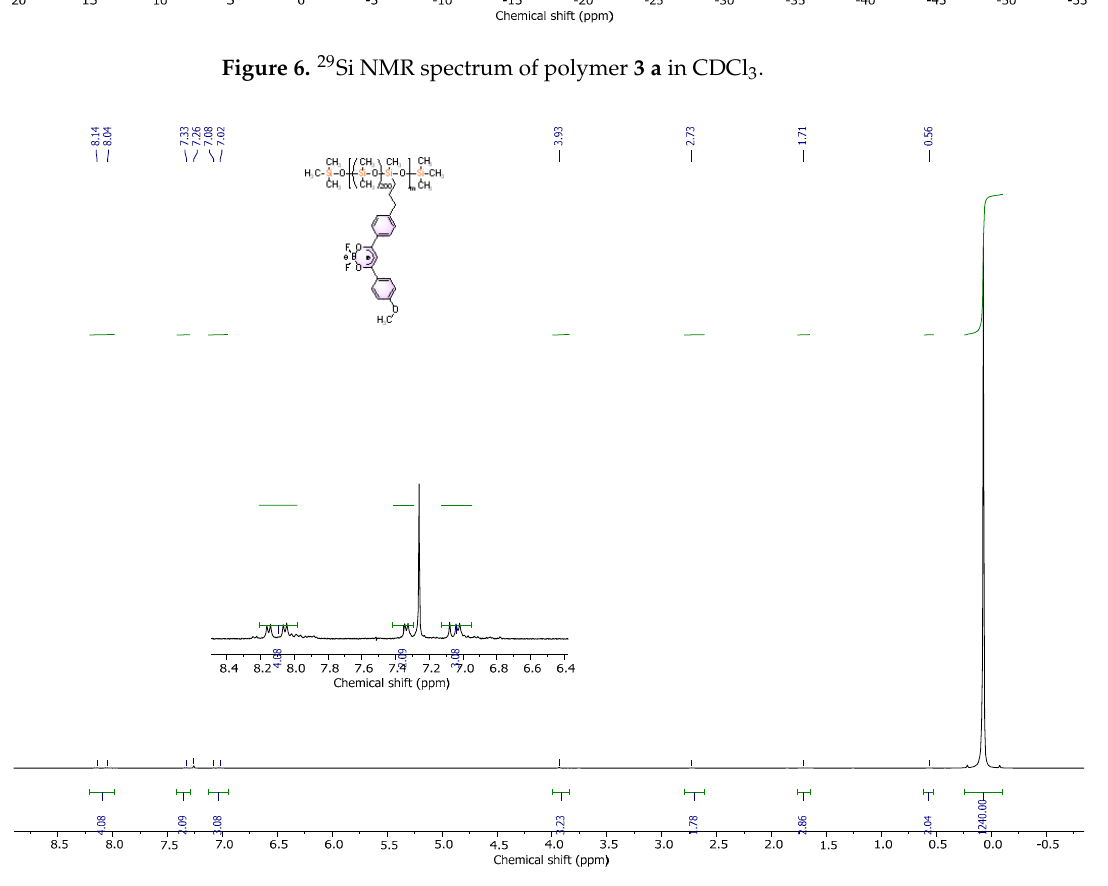
Figure 7. 1 H NMR spectrum of polymer 3 b in CDCl 3 .